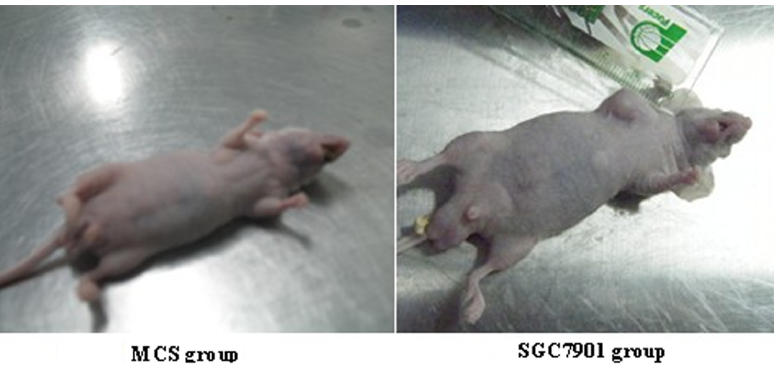
Figure 7. The hUC-MSC group (passage 15) of nude mice showed no tumor formation 4 weeks after the cells were implanted. However, the SGC7901 group developed tumors after 4